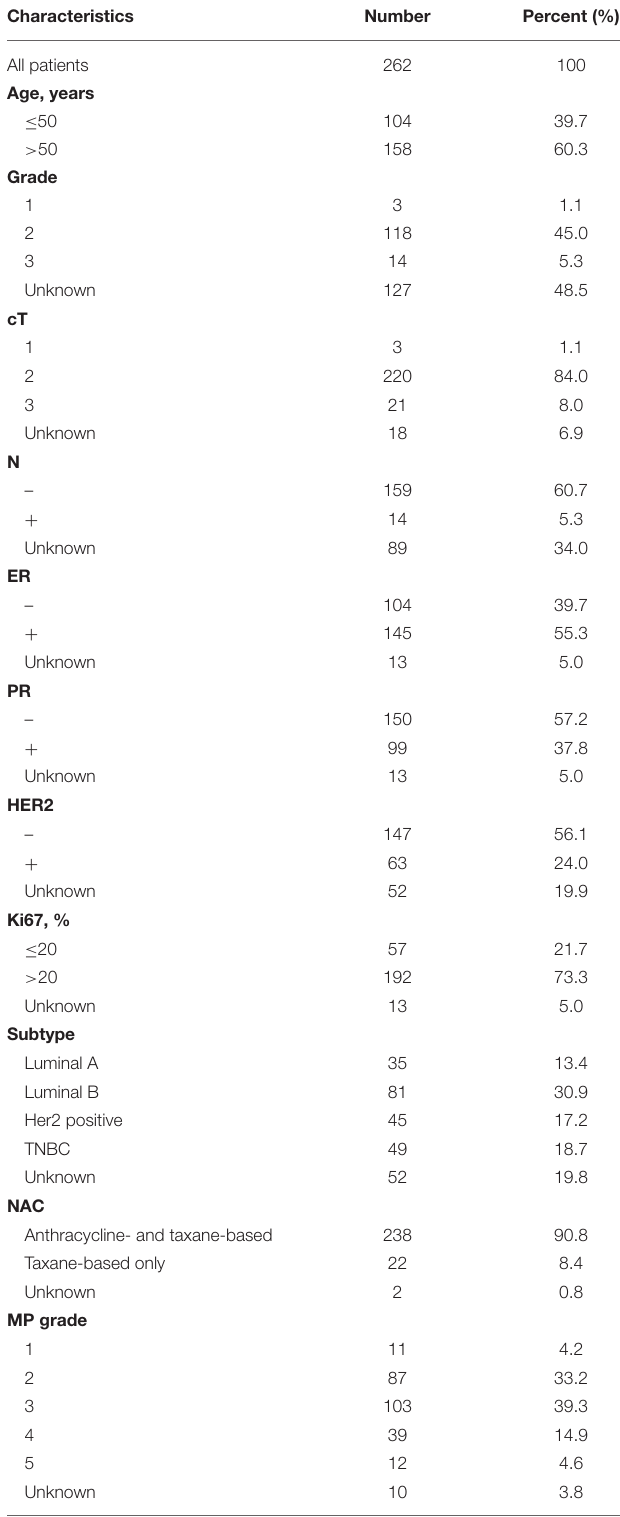
TABLE 1 | Clinicopathological characteristics of patients when diagnosed.